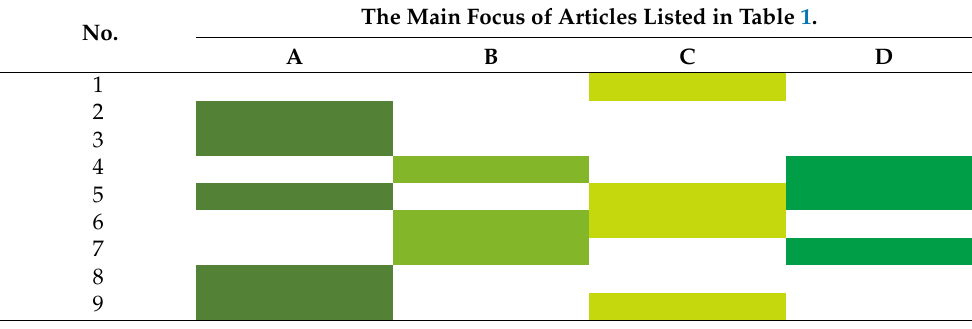
Table 2. The main article’s themes, based on the results of the articles listed in Table 1. The Main Focus of Articles Listed in Table 1. No.